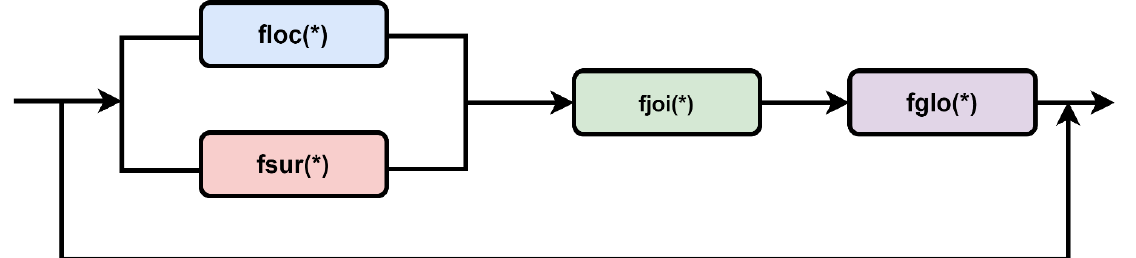
Figure 2. Structure of CGblock used in the CGNet.